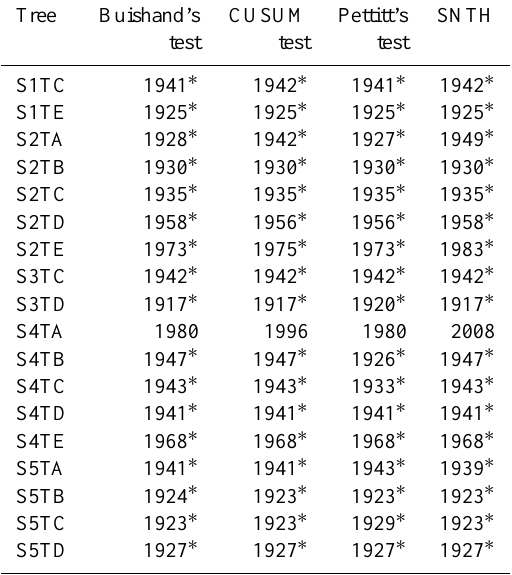
Table 3. Estimation of the timing of when a significant change in mean of δ 15 N could be detected for each tree utilizing the four dif- ferent breakpoint tests described in the methods sections. The aster- isks indicate that the test detected a significant breakpoint <0.05 for a given year. Note that the timing of when a significant change was detected may differ based on the statistical method used, and note also that the trees with positive trends were not included in these tests.